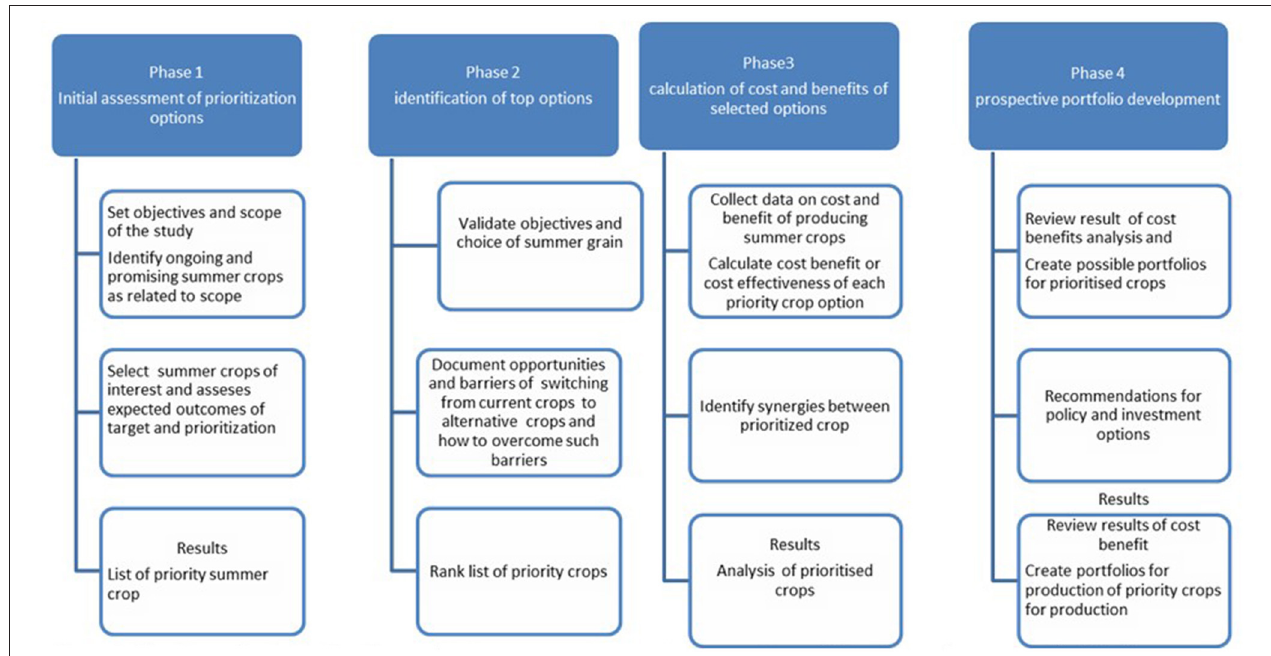
FIGURE 1 | Targeting and prioritization framework for summer grain production compromising prioritization options, option indication, cost-benefit analysis, and portfolio development (adapted from Campbell et al., 2016; Andrieu et al., 2017).